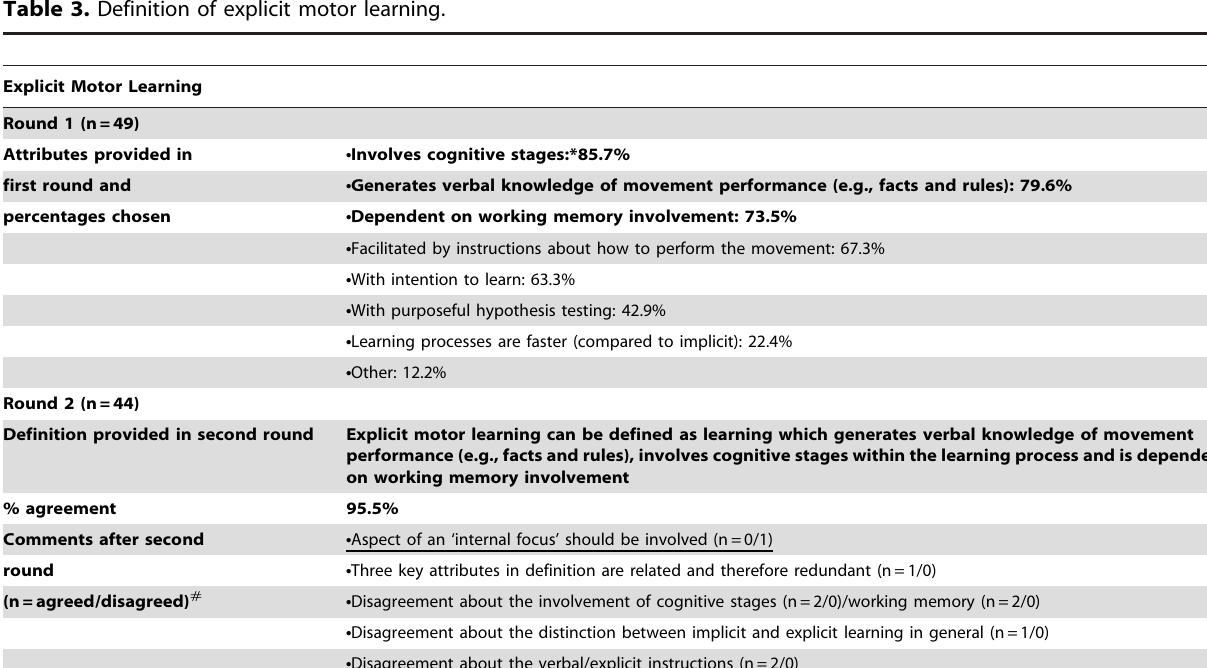
Table 3. Definition of explicit motor learning.